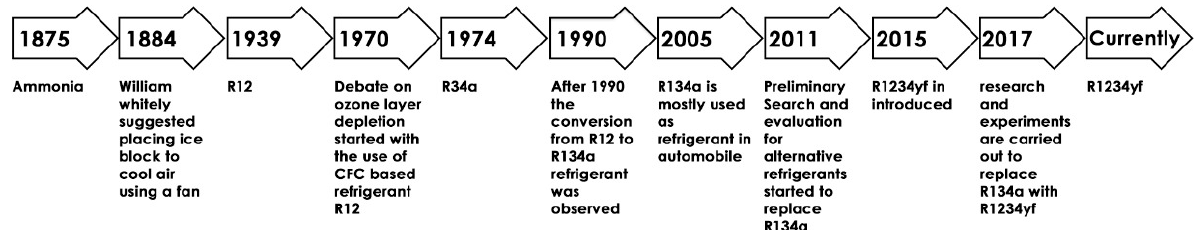
Figure 8. Evolution of refrigerant.